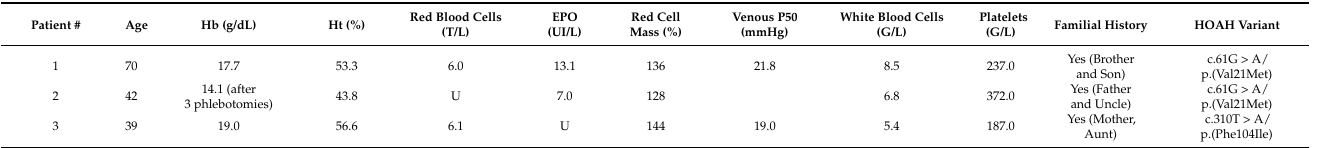
Table 2. Clinical and biological data of the 3